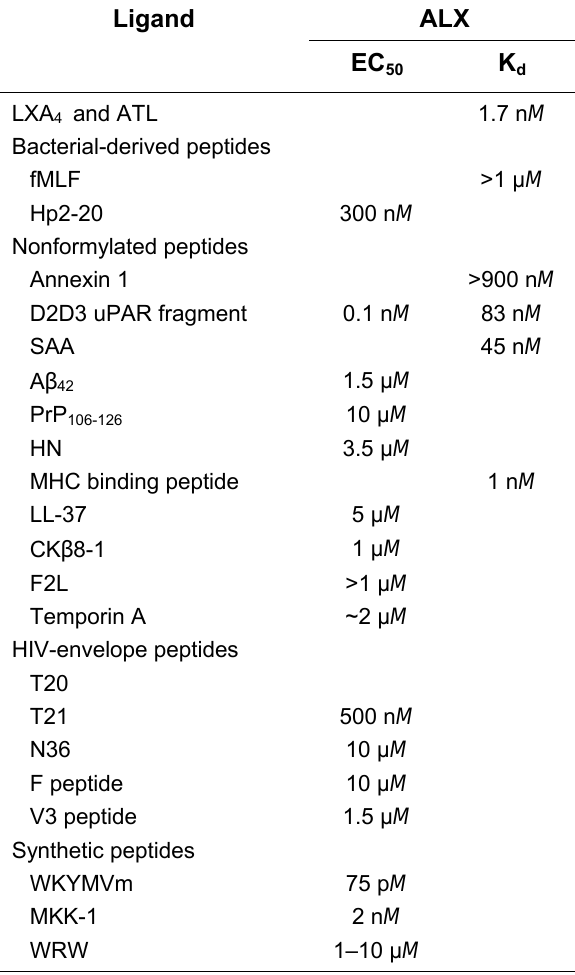
Characteristics of ALX